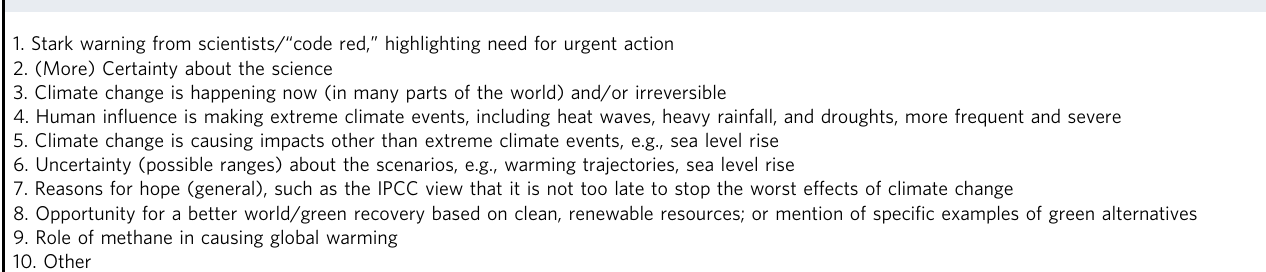
Table 2 Main IPCC messages